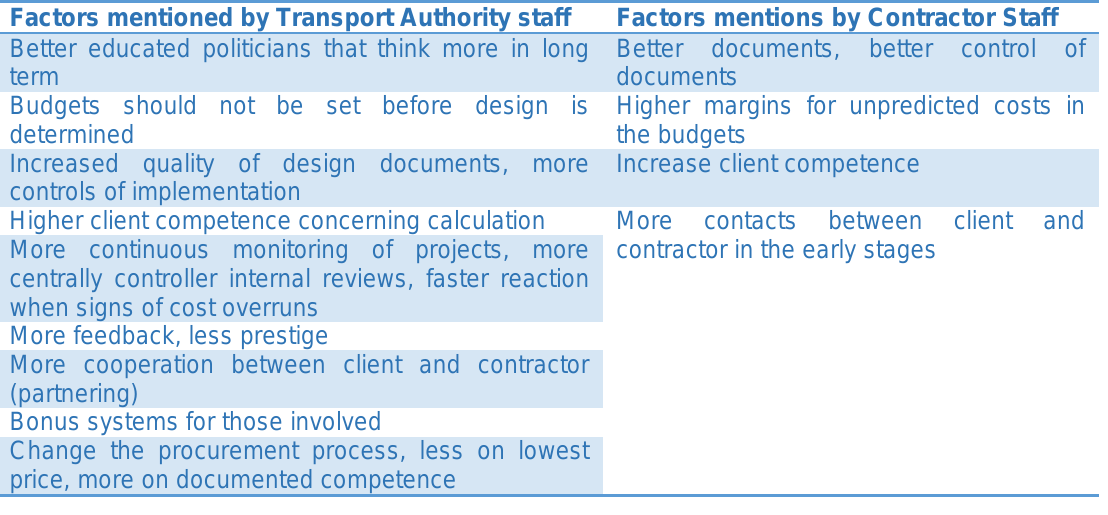
Table 9: Other measures that can reduce cost overruns Factors mentioned by Transport Authority